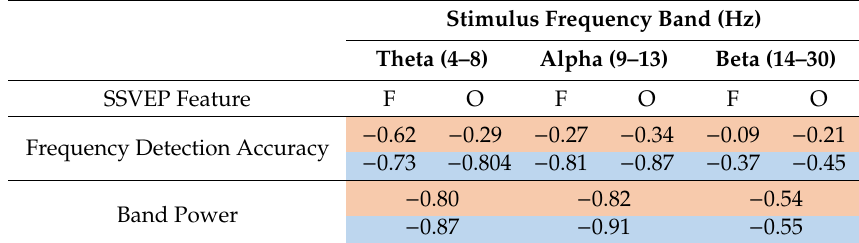
Table 4. Coefficients of correlation with age for SSVEP band power and stimulus frequency detection accuracy including (light beige) and excluding (light blue) age group 10–20.